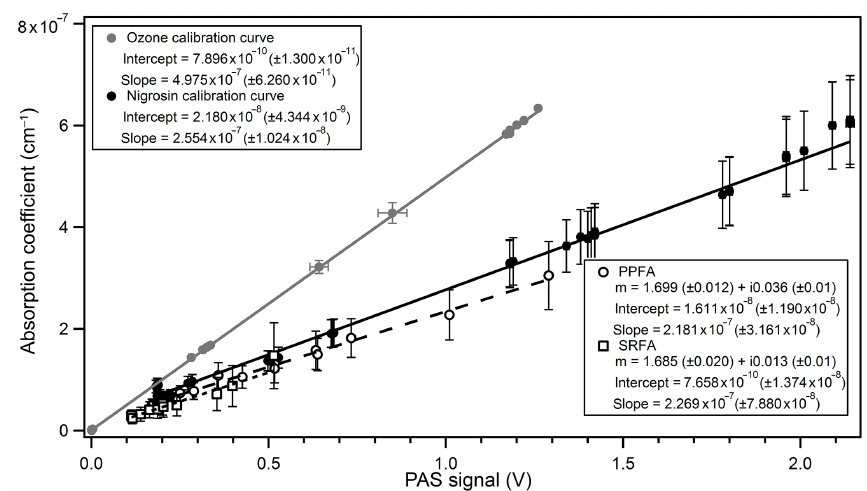
Figure 5. PAS O 3 calibration curve and regression (gray), nigrosin calibration curve and regression based on SE analysis (black circles and line) and PPFA and SRFA based on complex RI retrieval from CRD-S measurements and aqueous UV–vis measurements. Absorption coefficients for the nigrosin, SRFA and PPFA were calculated using Mie theory routine.